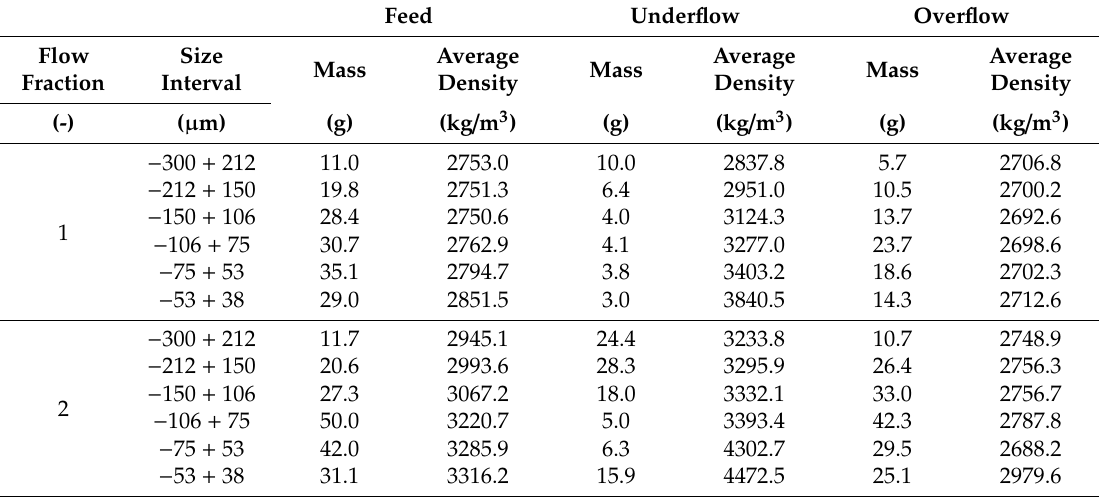
Table A1. Raw-sized pycnometry data for chromite ore LST flow fractionation of samples of the feed, underflow and